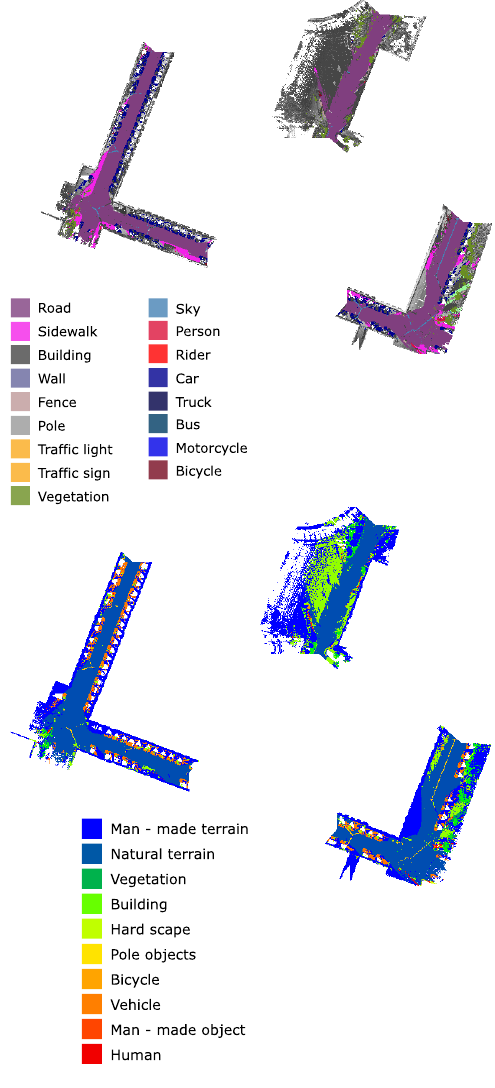
Figure 12. Classes from segmented images of the front-left MMS camera projected onto the Testset 1. Upper image shows the original classification scheme and image below point cloud reclassified for evaluation